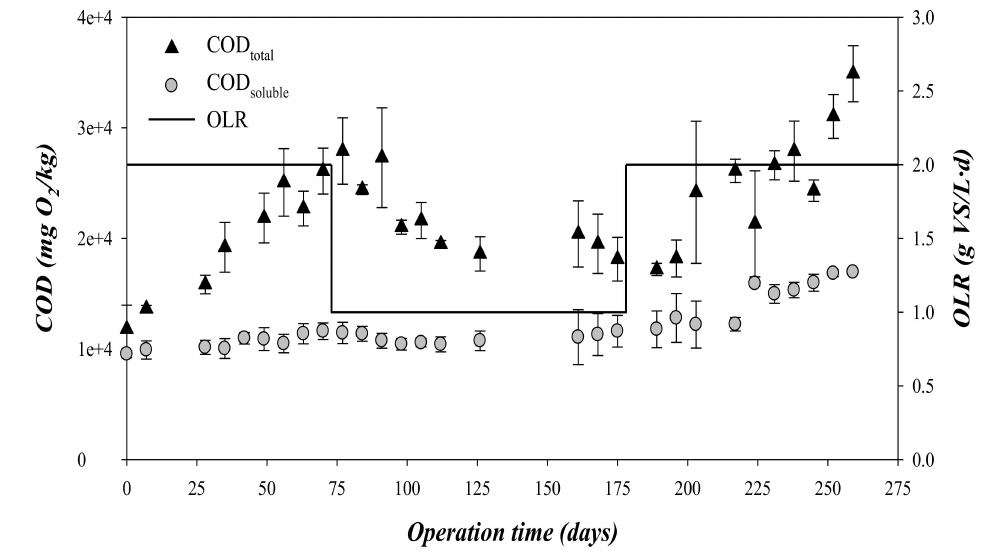
Figure 3. Variation of the total and soluble COD and the organic loading rate (OLR) during operation